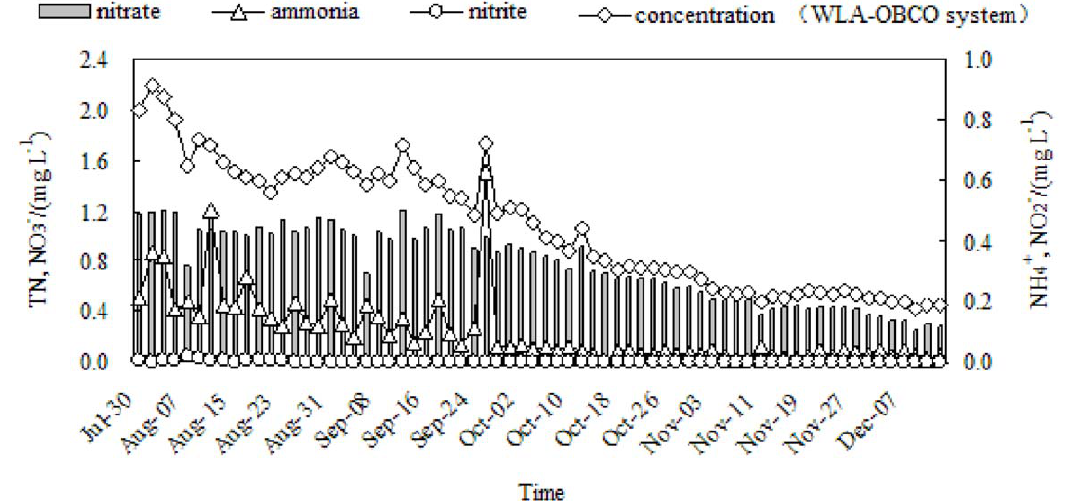
Figure 2. Variation of nitrogen pollutants concentrations for WLA-OBCO combined system during operation.